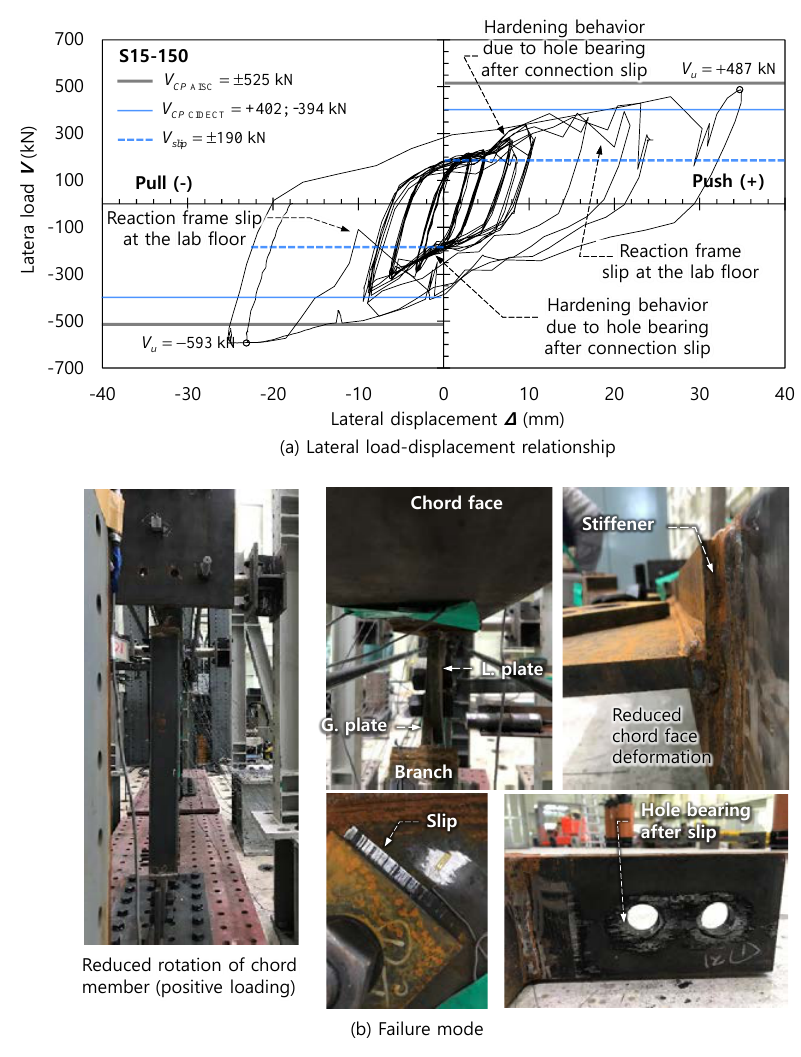
10 of 18 Figure 6. Test results of unstiffened plate-to-RHS connection: N00-150: ( a ) Lateral load-displacement relationship; ( b ) Failure mode. Figure 7 shows the test results of the stiffened specimen S15-150. For S15-150, out-of-plane rotation and torsional effects were greatly reduced. As shown in Figure 7a, after robust initial elastic behavior, the stiffness decreased due to slip at the bolted joint of branch members at the load level of about V = ±200 kN; however, the strength and stiffness began to increase again, as the bolt was in contact with the hole edge and bearing action was activated. The maximum load in the positive direction, V u = +487 kN, was less than that in the negative direction, V u = − 593 kN, due to torsional effects during the push in the positive direction. Note that, during the pull in the negative direction, S15-150 was not fully tested until its ultimate limit state due to the loading limit of the actuator (i.e., 650 kN). At the load level of V = ±400 kN, the load was sharply reduced as the reaction frame slipped on the floor; however, the load was recovered soon after. As shown in Figure 7b, the deformations of the connecting chord face ( t = 4.5 mm and b / t = 33.3) and longitudinal plate ( t